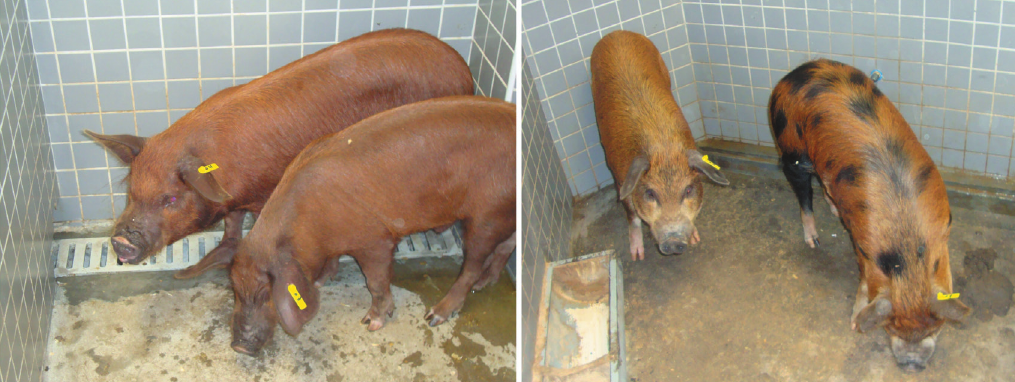
Figure 1- Adult male Brazilian miniature pigs